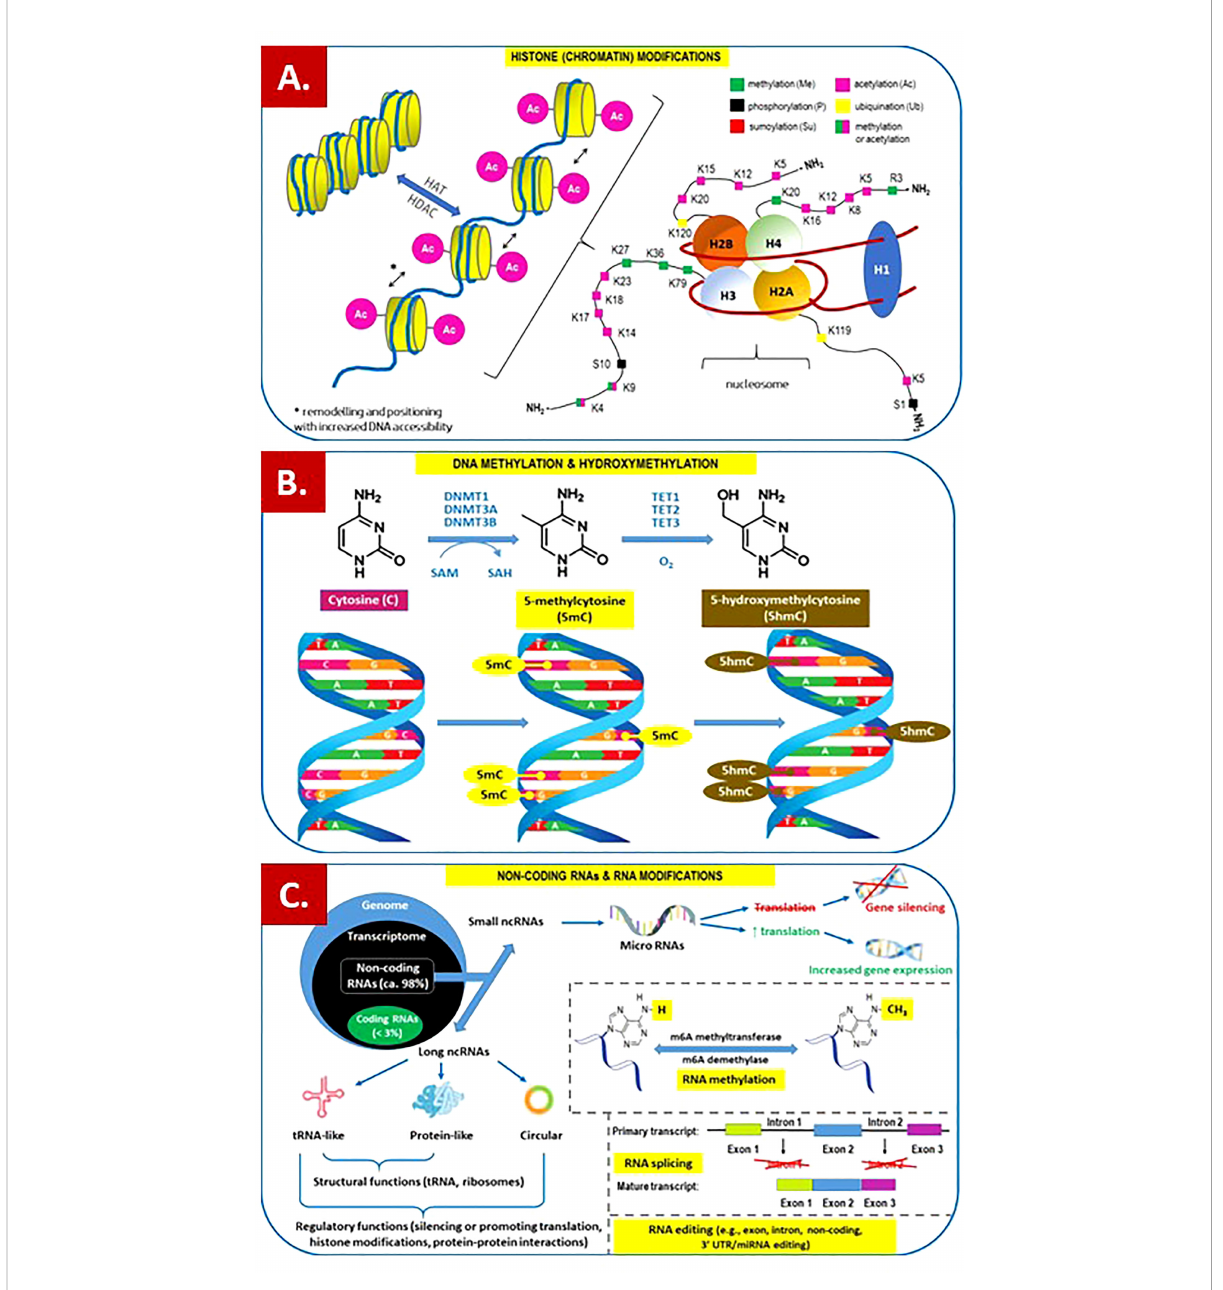
FIGURE 1 Overviewof themainepigeneticmechanismsthat regulate geneexpressionand may establishpotentiallyheritablechangesingene expressionwithout alteringtheunderlyingDNAnucleotide sequence. (A) Histone(chromatin)modi fi cations. On theleft. Chromatinremodelingisthedynamicmodi fi cationof chromatinarchitecture toallowaccess of condensedgenomicDNAtotheregulatorytranscriptionmachineryproteins, andthereby control